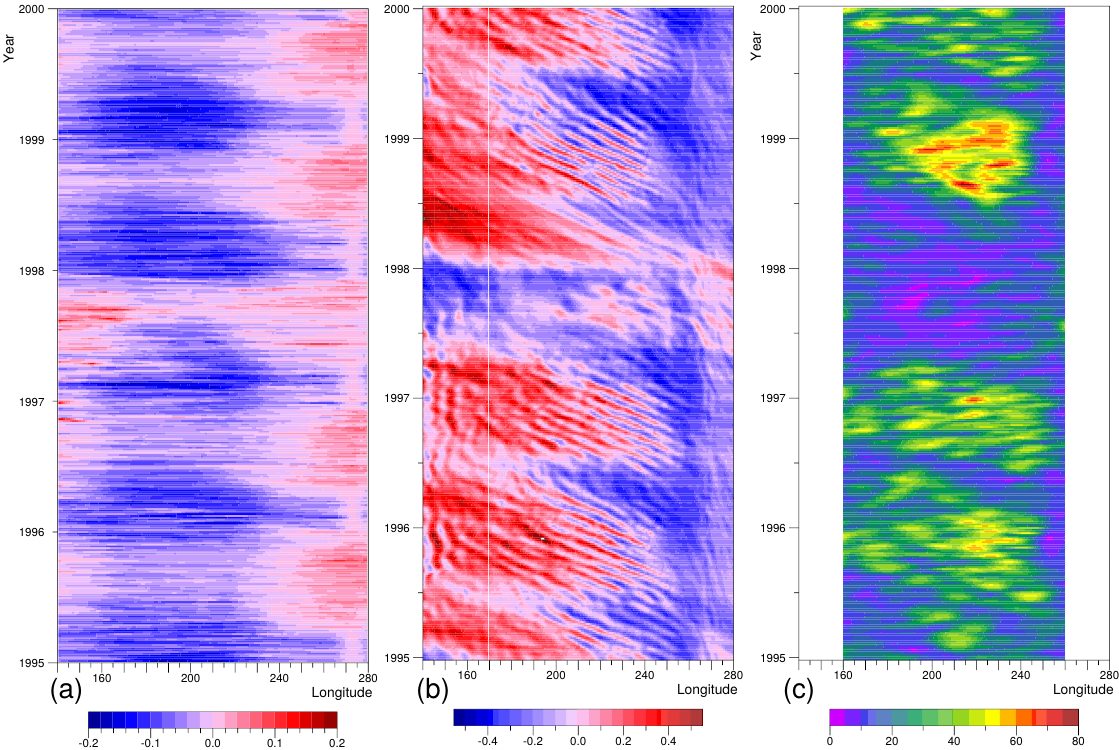
Figure 29. Values at 6 ◦ N, during the period 1995 to 2000, of (a) the eastward component of the wind stress (Pa), (b) the pressure integral (10 6 Pam) of Eq. (4) at 300m and (c) the rms northward transport variability V rms (m 2 s − 1 ).